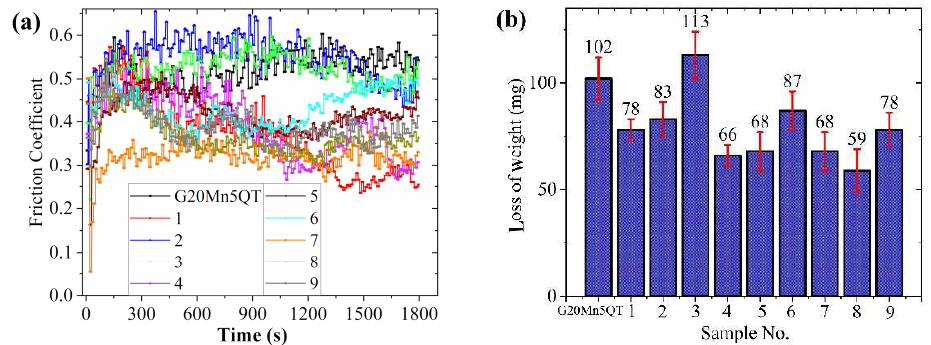
Figure 13. Frictional wear test results: ( a ) friction coefficient; ( b ) loss of weight by wear.